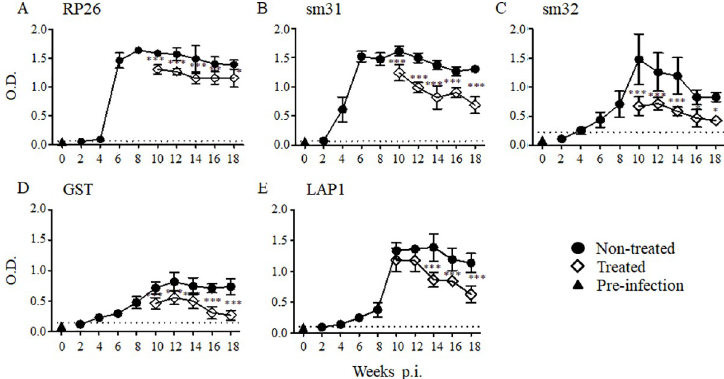
Fig 1. IgG responses to the S . mansoni antigens during S . mansoni infection and after the treatment. In each group, five mice were infected with 50 S . mansoni cercariae, and the sera were collected at each time point. A group of mice was orally treated twice with 500 mg/kg PZQ at 8 weeks post-infection. The experiment was repeated for 3 times and the representative data are presented. The means of the IgG level to the S . mansoni recombinant RP26 (A), sm31 (B), sm32 (C), GST (D), and LAP1 (E) are shown with the standard errors. The dashed line represents the cut-off value (mean + 3SD of the OD of the pre-infected group). The IgG levels of the treated group (open diamonds) are compared with those of the untreated group (closed circles) and with those of pre-infection samples taken at week 0 (closed triangles). � p < 0.05, �� p < 0.01, and ��� p < 0.001. https://doi.org/10.1371/journal.pntd.0008518.g001 against the recombinant antigens was first detectable in the sera at 4 weeks post-infection, as was the IgG raised against SWAP and SEA, whereas the IgG raised against tropomyosin was detected in the sera from 2 weeks post-infection, earlier than the other antigens (Figs 1 and 2) . The IgG raised against RP26 and sm31 rapidly and dramatically increased, peaking at 6 weeks post-infection (Fig 1A and 1B) . The IgG raised against sm32, GST, LAP1, filamin, LAP2, and tropomyosin peaked at 10–12 weeks post-infection, and then remained unchanged or decreased (Figs 1C–1E, 2A, 2B and 2D) . The IgG raised against serpin gradually and consis- tently increased during the infection, showing a similar pattern to the kinetics of IgG raised